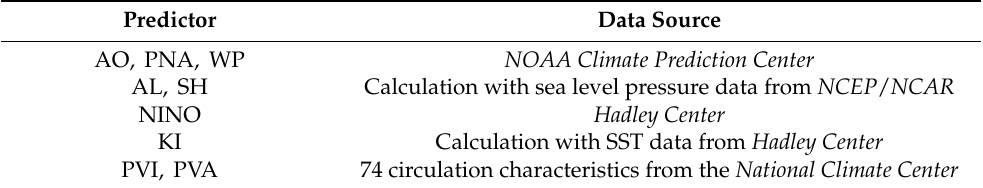
Table 1. Data sources of 9 predictors in STII prediction.